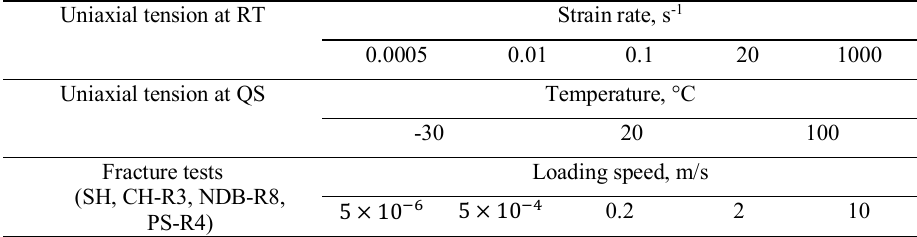
Table 1. Experimental program under different strain rates and